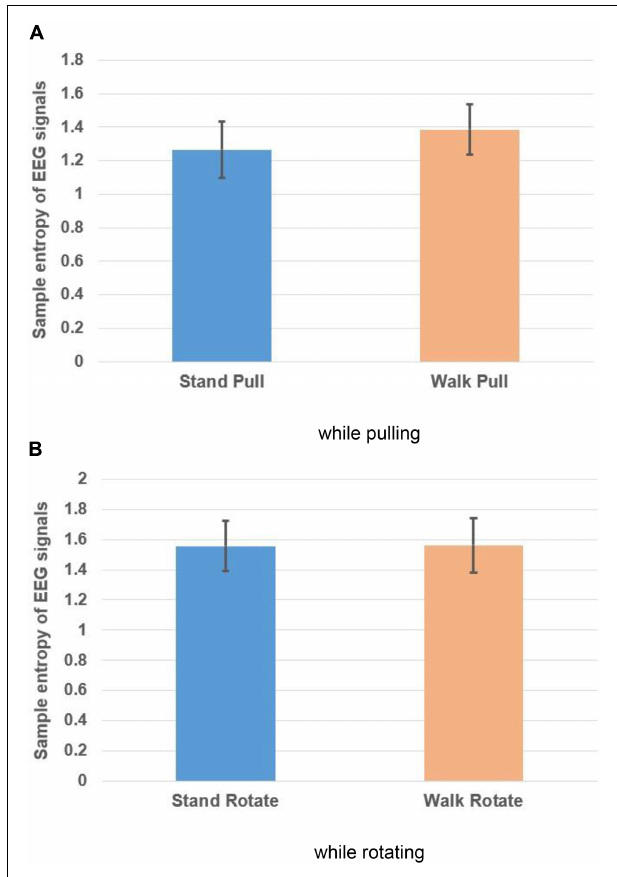
FIGURE 8 | Sample entropy of EEG signals in walking and standing while pulling (A) and rotating (B) . Error bars indicate standard deviation.